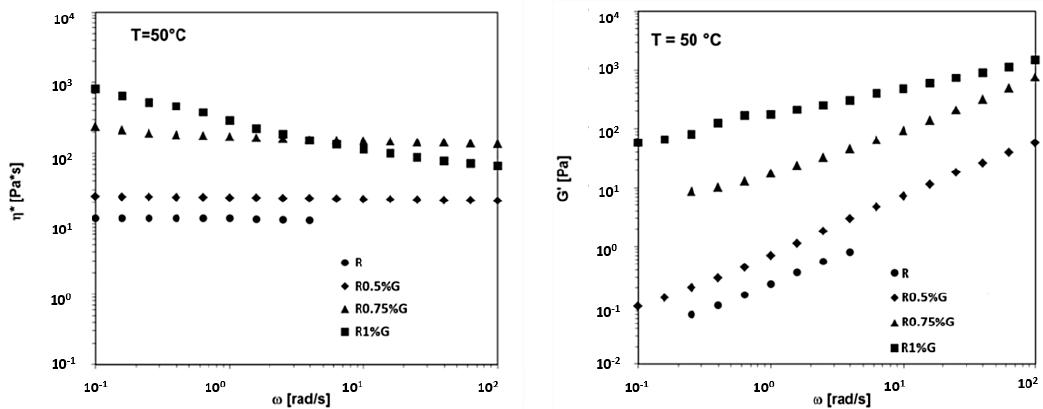
Figure 20. Rheological properties at T = 50 °C for the R uncured epoxy matrix, R0.5%G, R0.75%G and the R1%G by wt liquid dispersions.